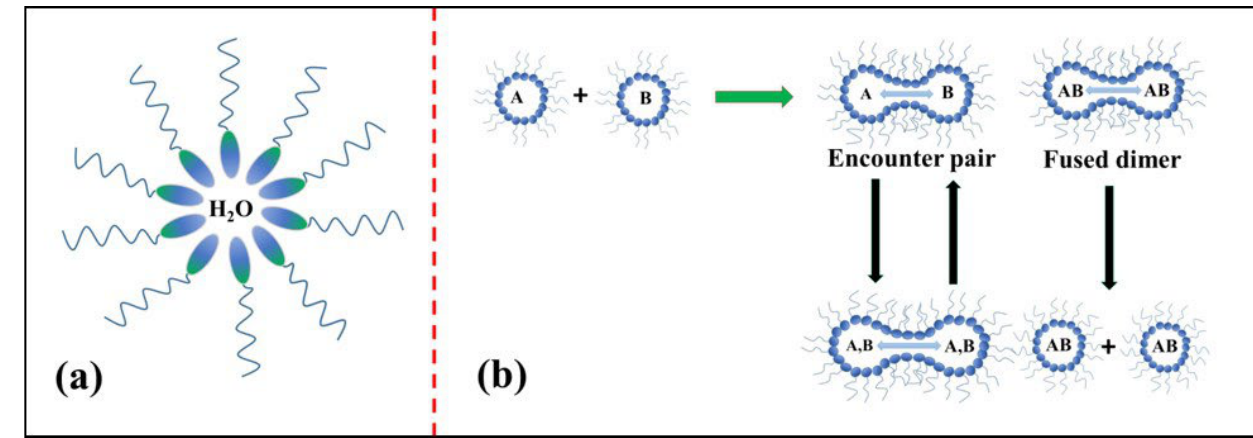
Figure 16. ( a ) Schematic of W/O microemulsion or reverse micelle; ( b ) mechanistic steps involved in the reverse micellar method.